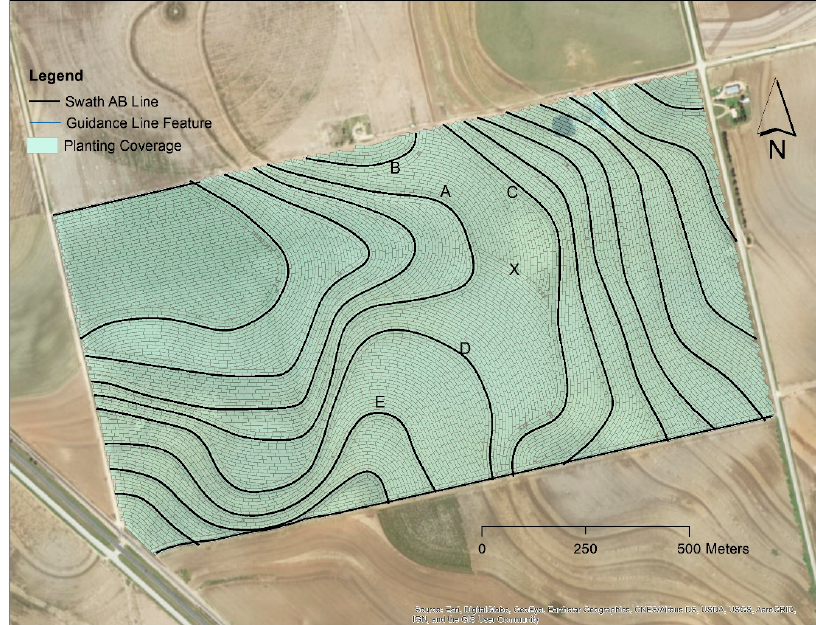
Figure 8. Planting coverage recorded by a real-time kinematic (RTK) guidance system showing guidance without confusions in multiple parcels in a field using guide-to-line features. The Trimble Autopilot guidance system has two modes of guidance operations, i.e., swath AB line guidance and guide-to-line guidance. In the guide-to-line mode, the guidance system only